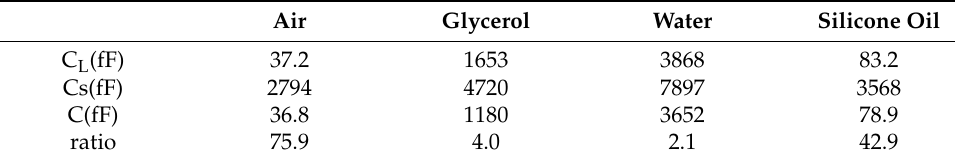
Table 2. Capacitance ratio of switches with different filler materials.